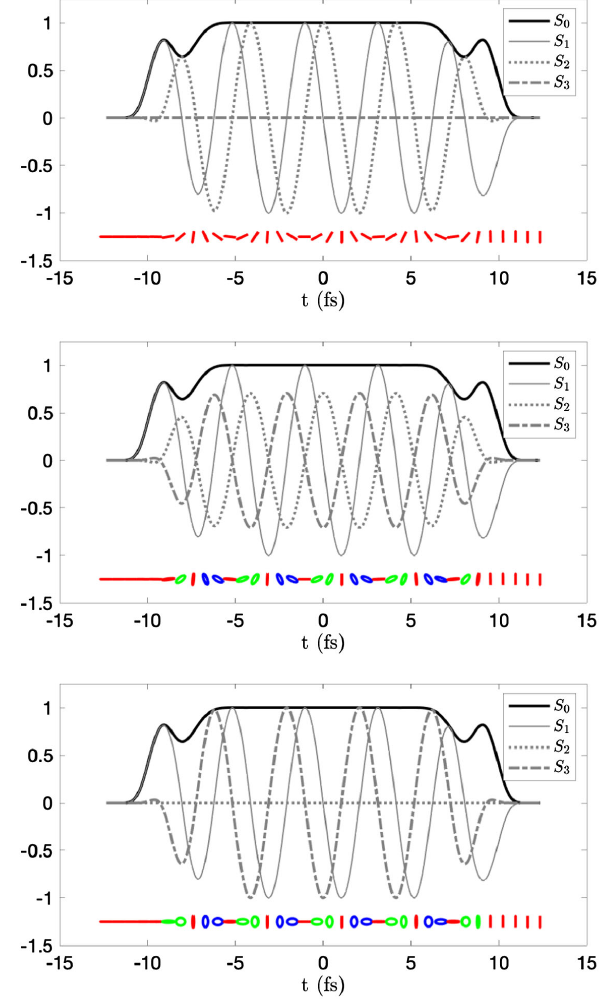
FIG. 2. Temporal Stokes parameters in Eq. (6) for crossed planar undulators, same parameters as Fig. 1. The relative phase is set to ϕ ¼ 0 (top), ϕ ¼ π = 4 (middle), and ϕ ¼ π = 2 (bottom). Also shown are the polarization ellipses along the pulse, with linear polarization red, ˆ e R polarization green, and ˆ e L polarization